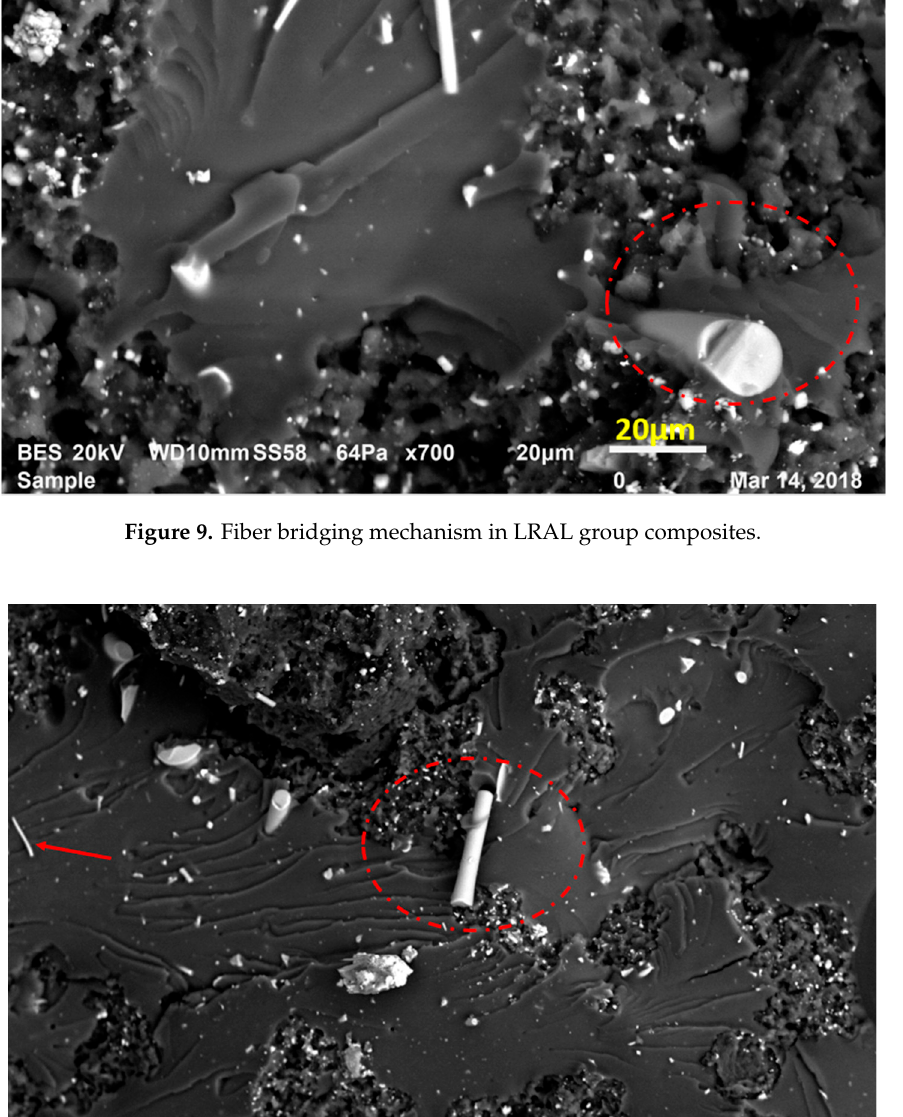
( b ) Figure 11. Shear yielding in LRAL composites. ( a ) LR2AL5 group, ( b ) LR2AL7.5 group. Fracture surface observation on the ternary composites showed different toughening mechanisms provided by AF and rubbers. AF bridging was seen as the main mechanisms that improve the composites’ fracture toughness. In addition, shear yielding is promoted by the presence of the recycled rubbers and AF. In conclusion, a good combination of different toughening mechanisms improved the fracture toughness of the manufactured composites. 4. Conclusions